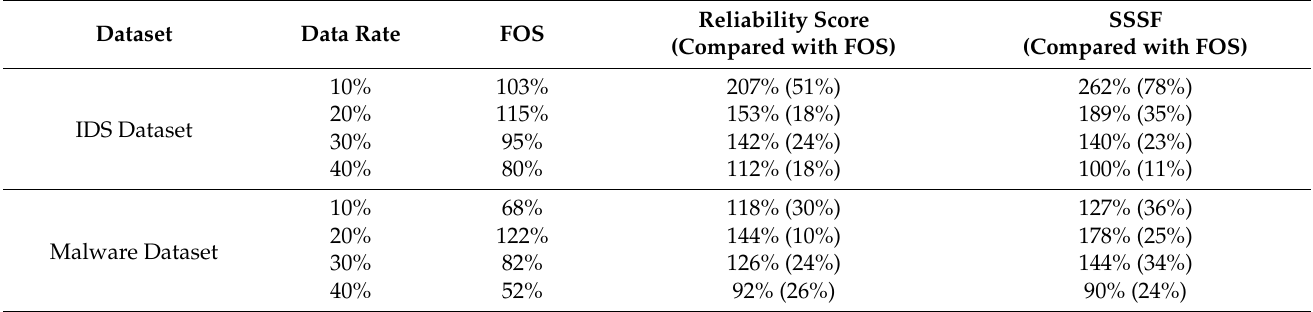
Figure 12. Error detection results when we analyzed the data in the order of highest analysis priority: ( a ) results of the experiment with the IDS dataset; ( b ) results of the experiment with the malware dataset. Table 7. Error detection comparison of unordered datasets and reliability analysis results.